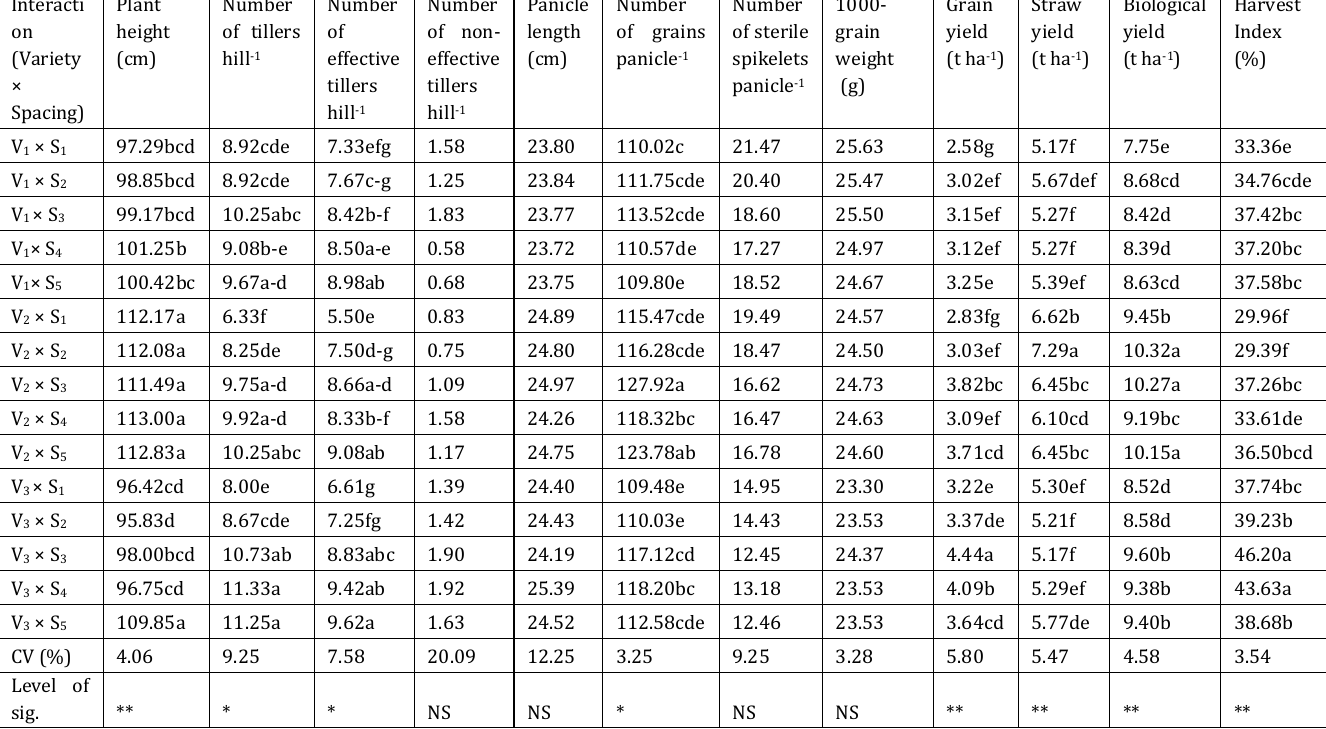
Table 3: Effect of interaction between variety and row spacing on yield contributing characters and yield of short duration transplant Aman rice varieties Interacti Plant on (Variety × Spacing)